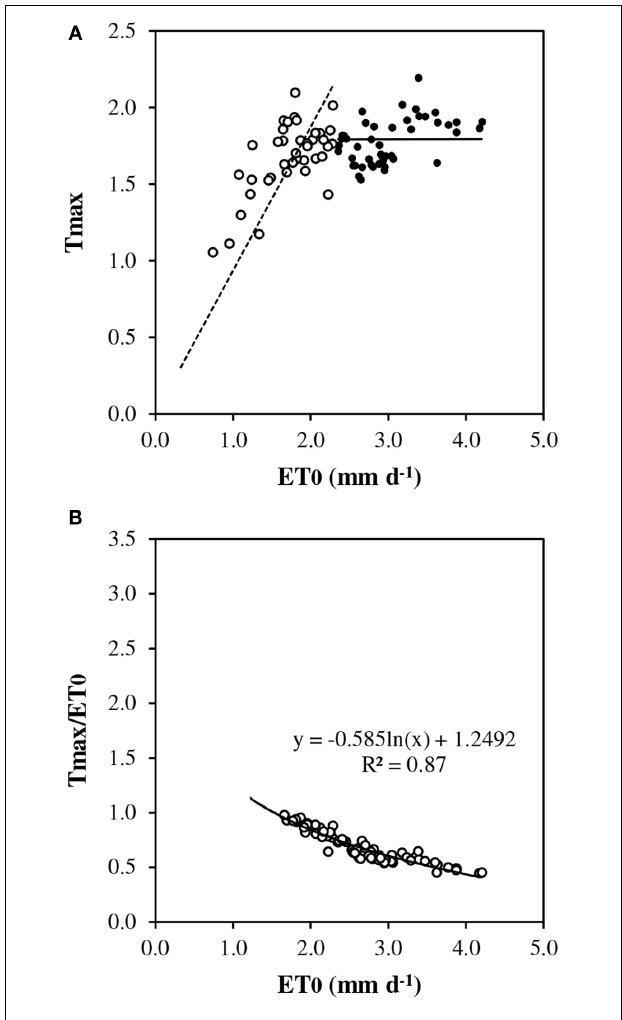
FIGURE 2 | Daily transpiration vs. reference evapotranspiration ( ET0 ): (A) measured maximum transpiration ( T max ) in the absence of soil water stress ( REW 0–0.6 ≥ 0.5), closed circles indicate ET0 > 2.3mm d − 1 , open circles indicate ET0 < 2.3mm d − 1 , dotted line represents the linear regression below 2.3 ET0 and crossing origin; (B) relative transpiration ( T max / ET0 ). - REWc was taken equal to 0.4 according to BILJOU99 frame- work and Figure 4 . - rET0c was calculated according the function deduced from Figure 2B : If ET 0 ≤ ET 0 c , rET 0 c = 1 If ET 0 > ET 0 c , rET0 c = a ∗ ln( ET0 ) + b with ET 0 c = 2 . 3 mm d − 1 , a = − 0 . 585 and b = 1 . 2492.